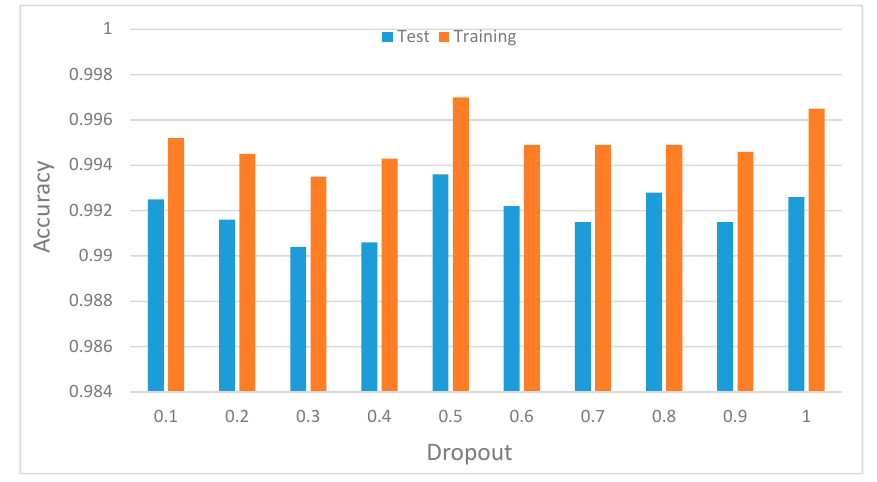
Figure 19. Model recognition accuracy with varying values of dropout probability.